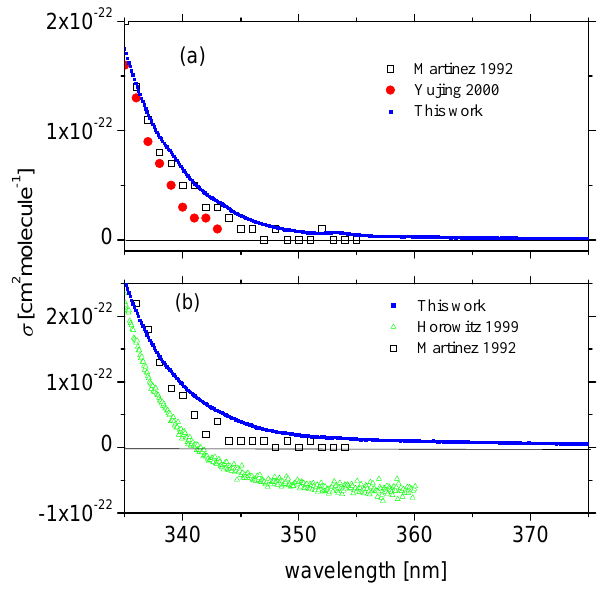
Fig. 8. Absorption cross-sections of (a) 2-butanone and (b) 2- Figure 8. Absorption cross-sections of (a) 2-butanone and (b) 2-pentanone. 2